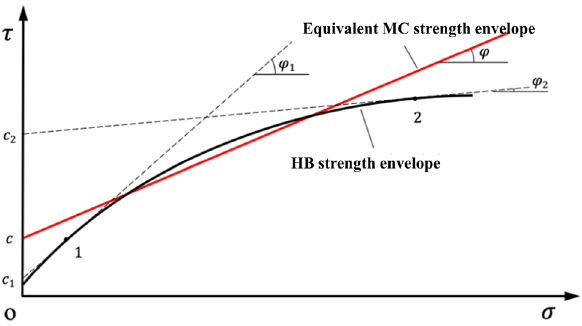
Figure 2. The relationship between the equivalent MC strength envelope curve and HB strength envelope curve.